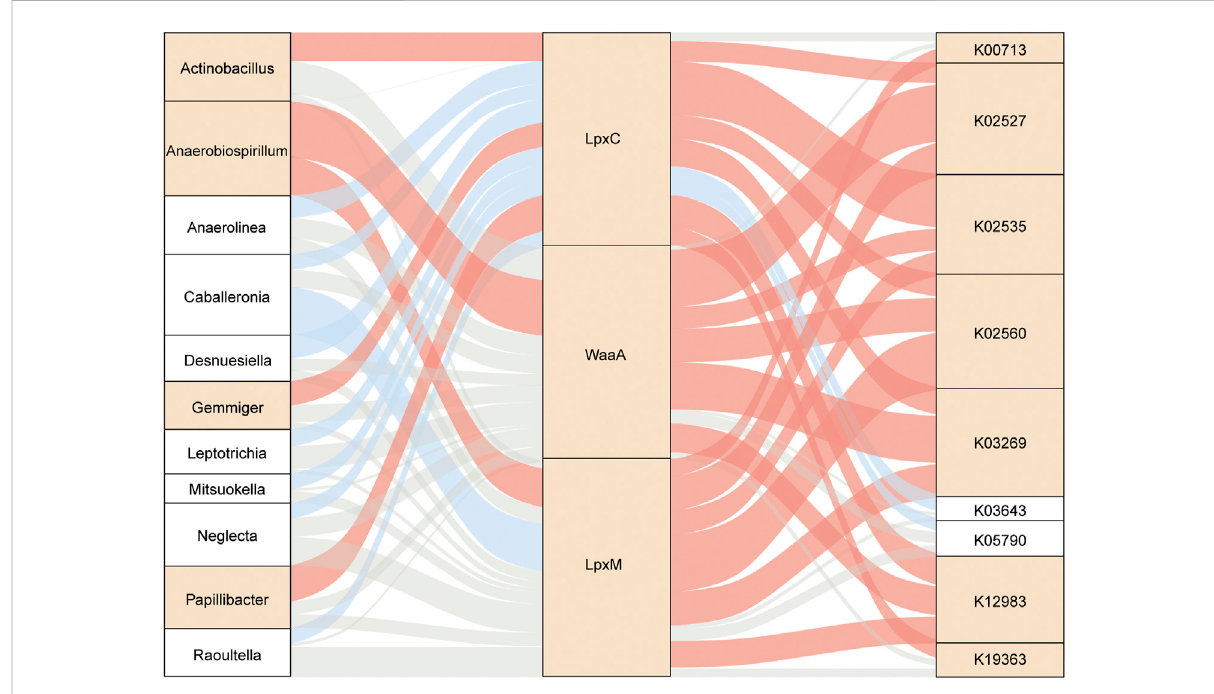
FIGURE 7 Interrelationship across gut microbes, LPS-biosynthesis-related enzymatic genes, and respective KOs. Sankey diagram based on Spearman correlation analysis. The gut microbes with the potential to produce LPS were related to LPS-biosynthesis-related enzymes and further linked to microbial KOsduring LPSbiosynthesis. Red,positive correlation( p < 0.05);blue,negativecorrelation( p < 0.05); gray, non-signi fi cantcorrelation( p ≥ 0.05). Square in yellow, enriched in T2D; square in white, enriched in NGT. T2D, type 2 diabetes; NGT, normal glucose